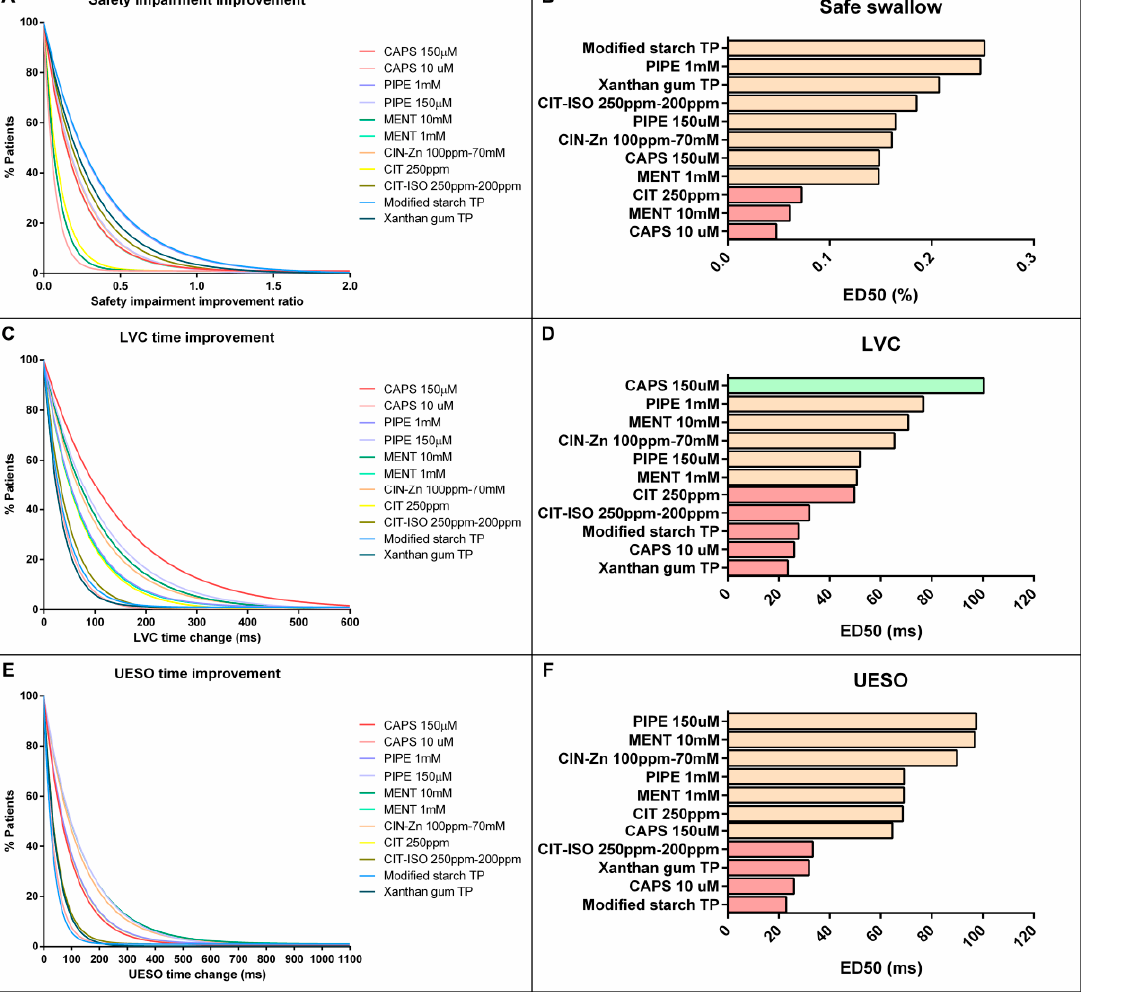
Figure 4. On the left, one-phase decay curves for the proportion of patients with improved signs of safety ( A ), time to LVC ( C ) and time to UESO ( E ). On the right, graphical representation of ED50 of each treatment classified as high (green bars), intermediate (orange bars) and low (red bars) therapeutic effect for signs of safety ( B ), time to LVC ( D ) and time to UESO ( F ). CAPS: capsaicin; PIPE: piperine; MENT: menthol; CIN-Zn: cinnamaldehyde-zinc; CIT: citral; CIT-ISO: citral-isopulegol; TP: thickening product; LVC: laryngeal vestibule closure; UESO: upper esophageal sphincter opening.